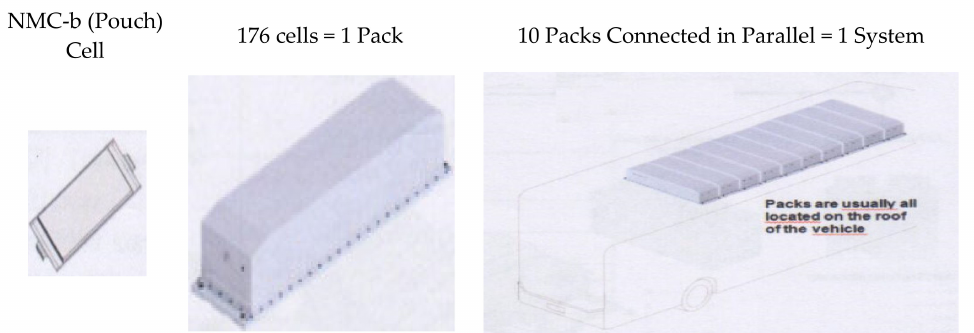
Figure 6. The installations of the NMC-b (pouch) type LIB.